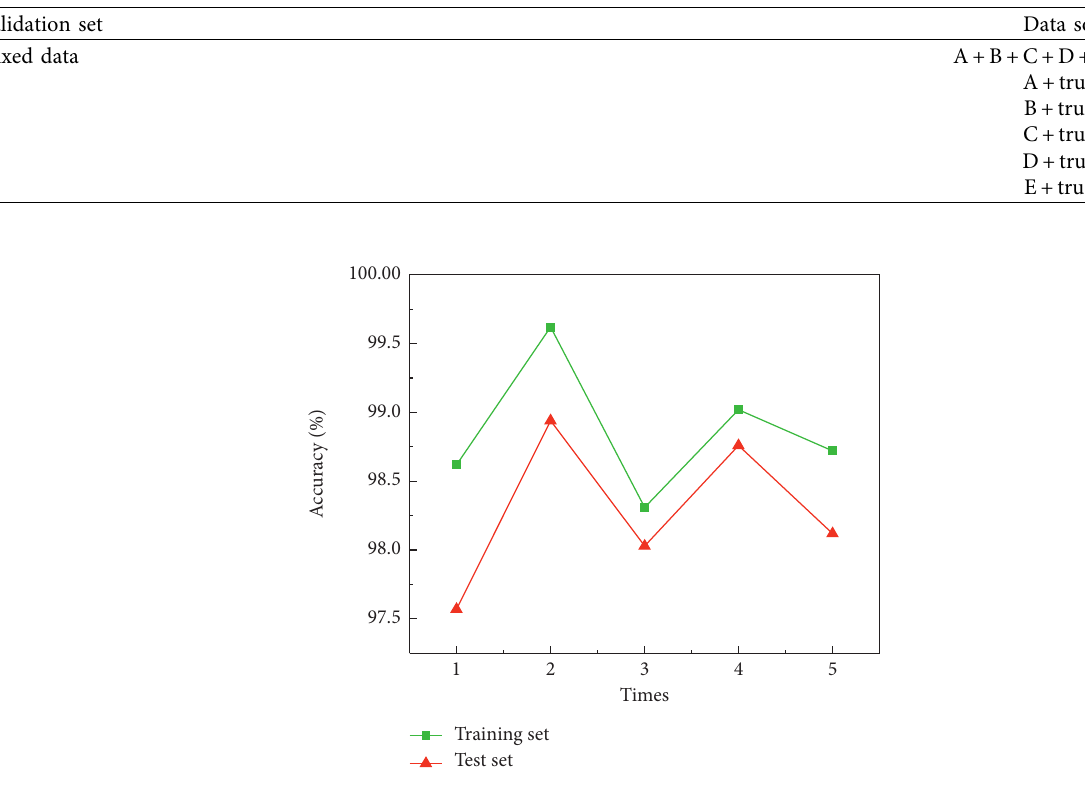
Figure 13: Accuracy of training and test sets.